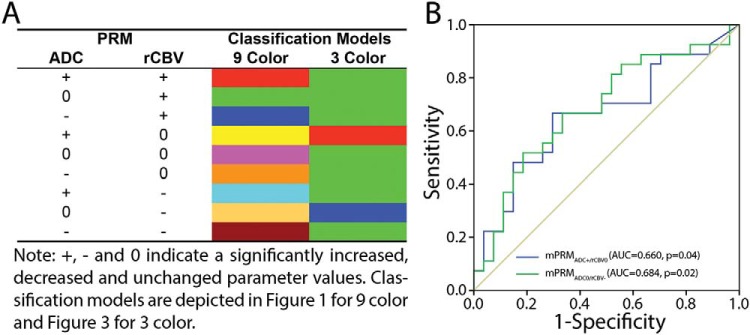
Assessment of predictive mPRM indices. (A) For ease of visualization, the 9 classes generated from the individual PRMs, in which plus (+), minus (−), and 0 represent voxel values that increase, decrease, or remain unchanged, respectively (color code demonstrated in Figure 1), were simplified to a 3-classification scheme. Voxels were color-coded as red for mPRMADC+/rCBV0, blue for mPRMADC0/rCBV−, and green for the remaining 7 classifications. (B) Predictive mPRM indices were identified by assessing the potential of the 9 indices to predict 1-year survival using an ROC analysis. Significant ROC stratification was observed in 2 of the 9 classes: mPRMADC+/rCBV0 and mPRMADC0/rCBV−. These results were used to determine the cutoffs that maximize both sensitivity and specificity for each metric. Cutoffs for response stratification were determined to have relative volumes (RVs) of 2.6% for mPRMADC+/rCBV0 (responders: RV ≥ 2.6%; nonresponders: RV < 2.6%) and 4.8% for mPRMADC0/rCBV− (responders: RV < 4.8%; nonresponders: RV ≥ 4.8%).